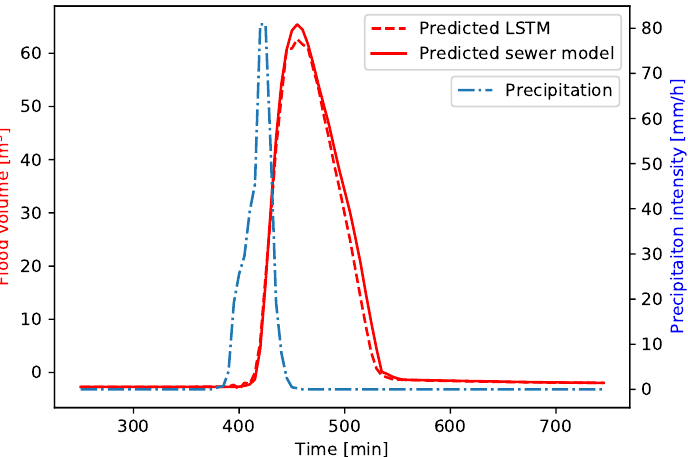
Figure 15. Flood volume time series, for the LSTM network validated on historic data, at a manhole in the centre of the area (NSE = 0.96).